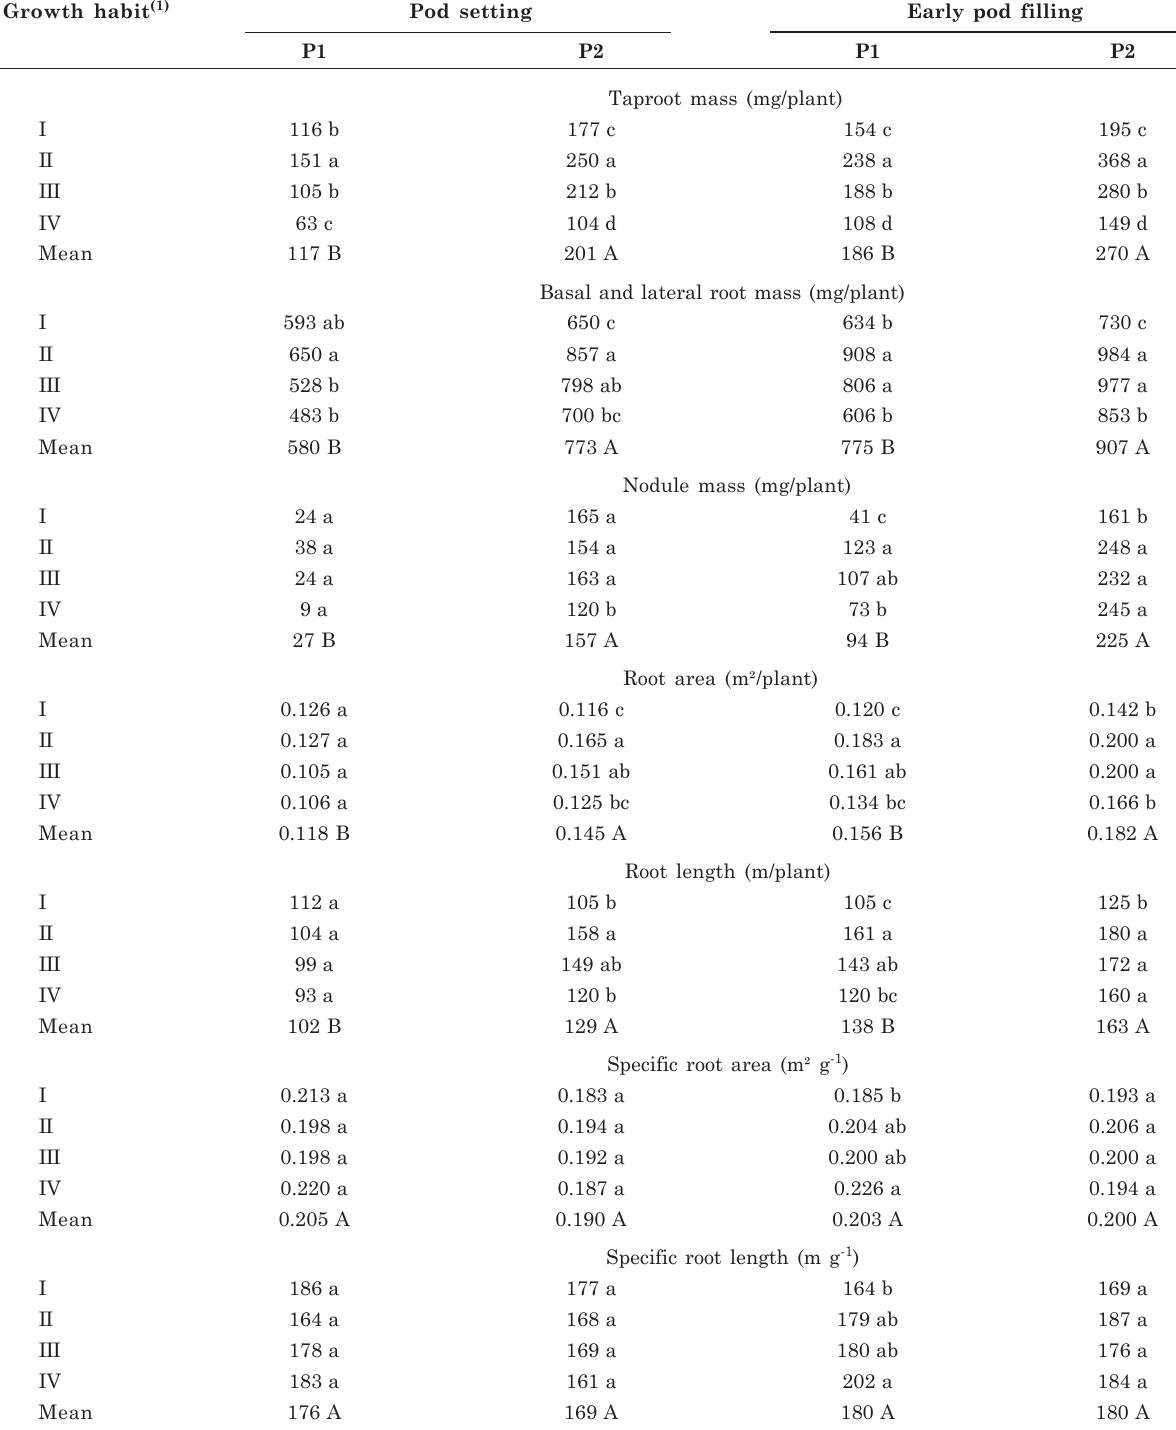
Table 3. Taproot mass, basal and lateral root mass, nodule mass, root area, root length, specific root area and specific root length, of 24 common bean genotypes grouped according with their growth habit, grown at two P levels applied to the soil (P1 and P2, respectively 20 and 80 mg kg -1 ), and at two growth stages (pod setting and early pod